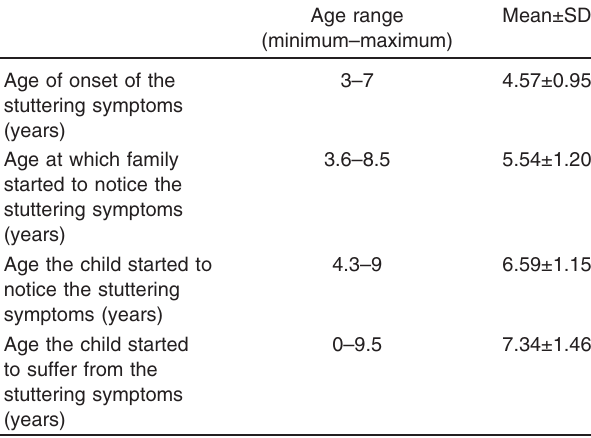
Table 2 Age of onset of stuttering symptoms, age at which the family noticed the stuttering symptoms, age the child start to notice the stuttering symptoms, and age the child started to suffer from stuttering symptoms